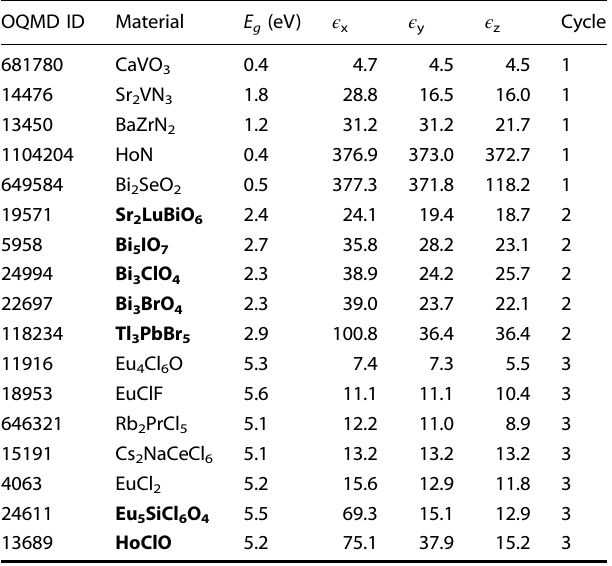
Table 2. Dielectric constants of 17 materials calculated using DFT in this